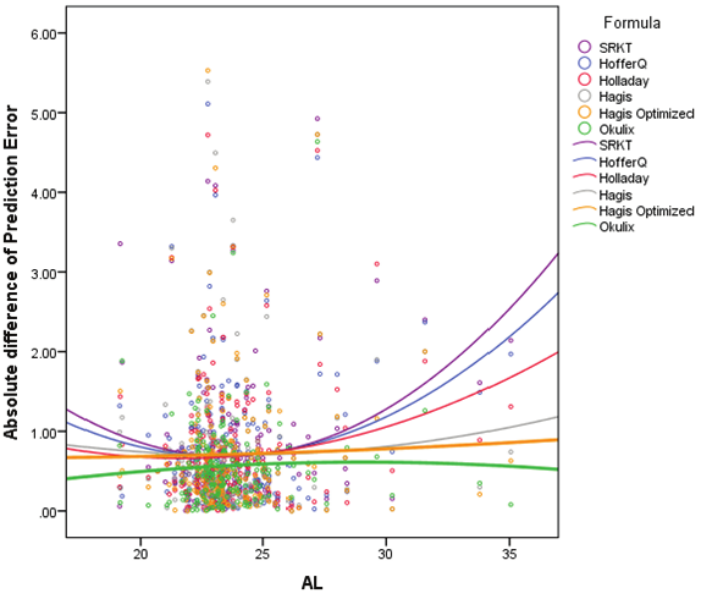
Figure 3. Percentage of eyes within the predicted refraction in each formula. Regarding the percentage of eyes within the predicted refractions of 0.25, 0.5, and 1 D, although the OKULIX had the highest proportion of the eyes in each group, the difference was not significant based on the generalized estimating equation analysis for the percentage of eyes within the 0.25 and 0.5 D. However, there was a significant difference in the percentages of eyes within 1 D of predicted refraction between the OKULIX and all the other formulas ( P <